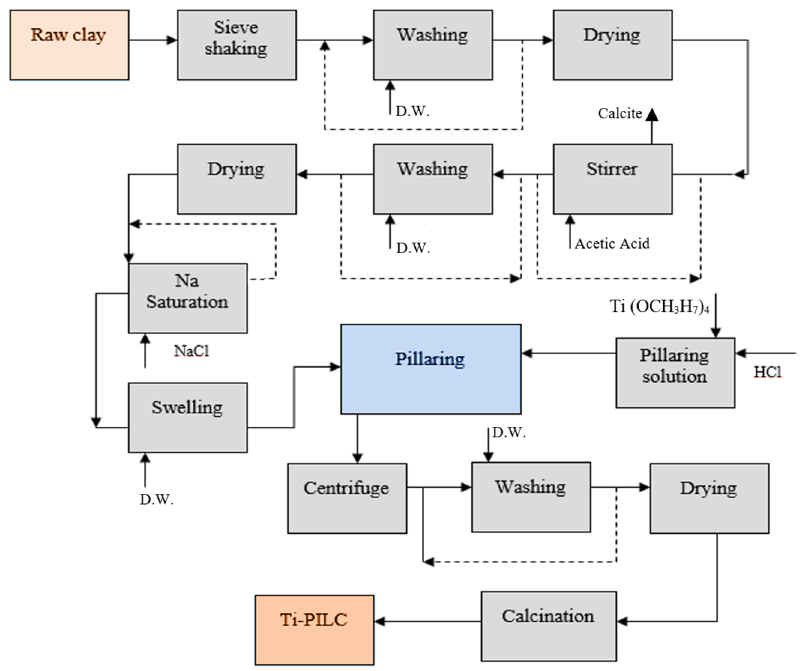
Figure 1. Schematic of titanium-pillared clay production